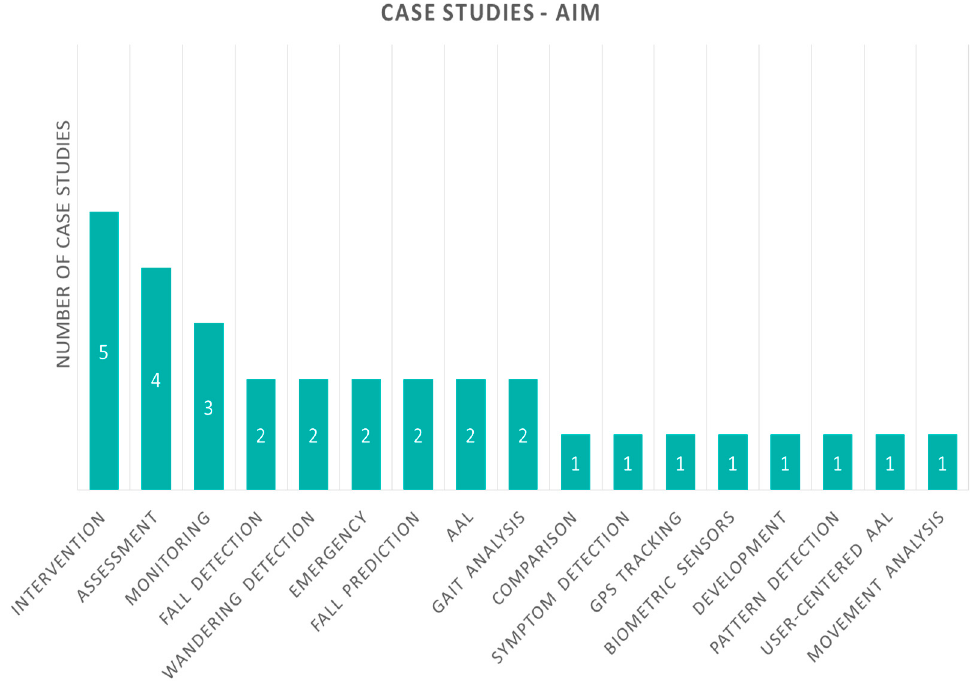
Figure 8. Case study papers according to their aim. AAL, ambient assisted living.